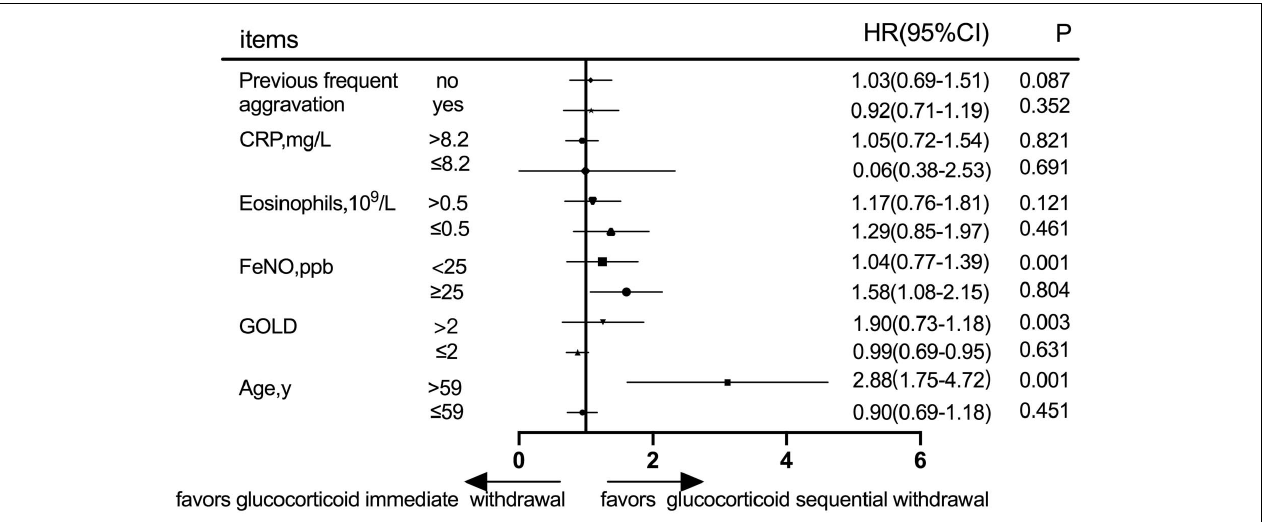
FIGURE 3 | Subgroup analysis according to previous frequent aggravation, CRP, eosinophils, FeNO, GOLD grade, and age at the 30-day follow-up. CRP, C-reactive protein; FeNO, Fractional exhaled nitric oxide; GOLD, global initiative for chronic obstructive lung disease.